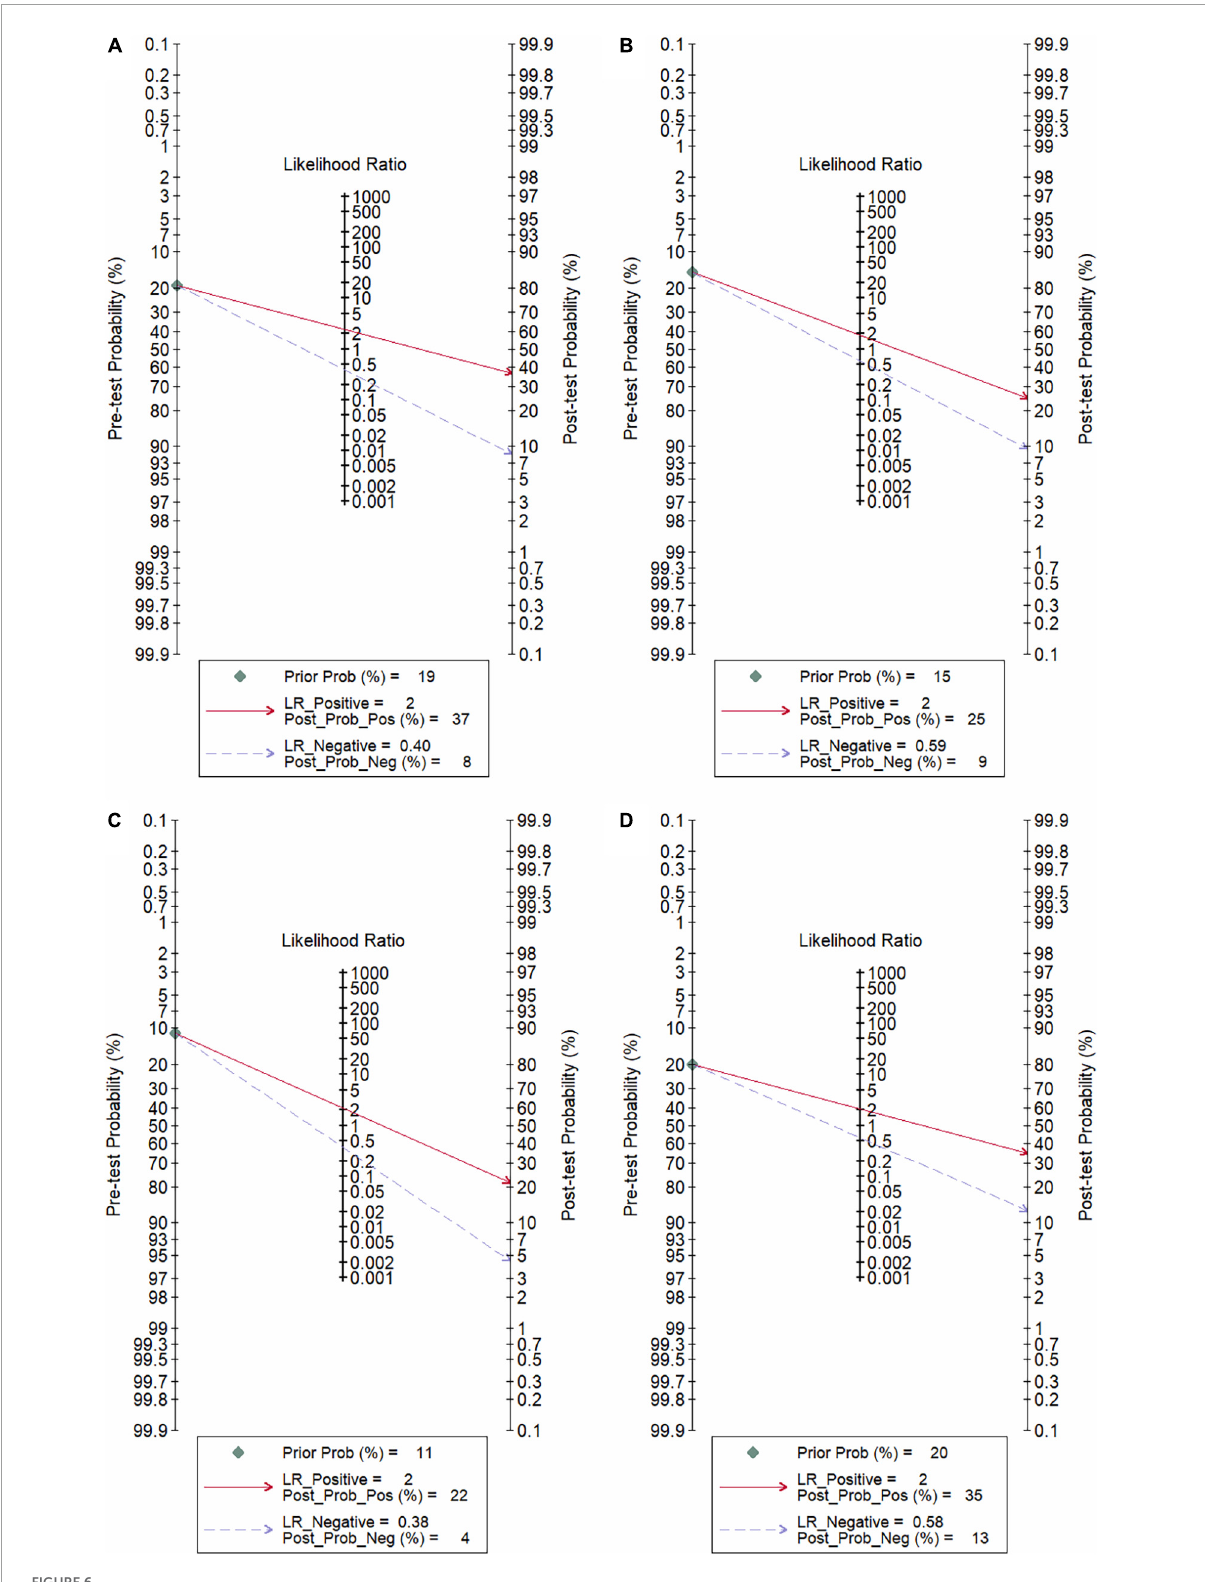
FIGURE6 Fagan plot (A) NLR; (B) PLR; (C) CRP; (D) NLR and PLR